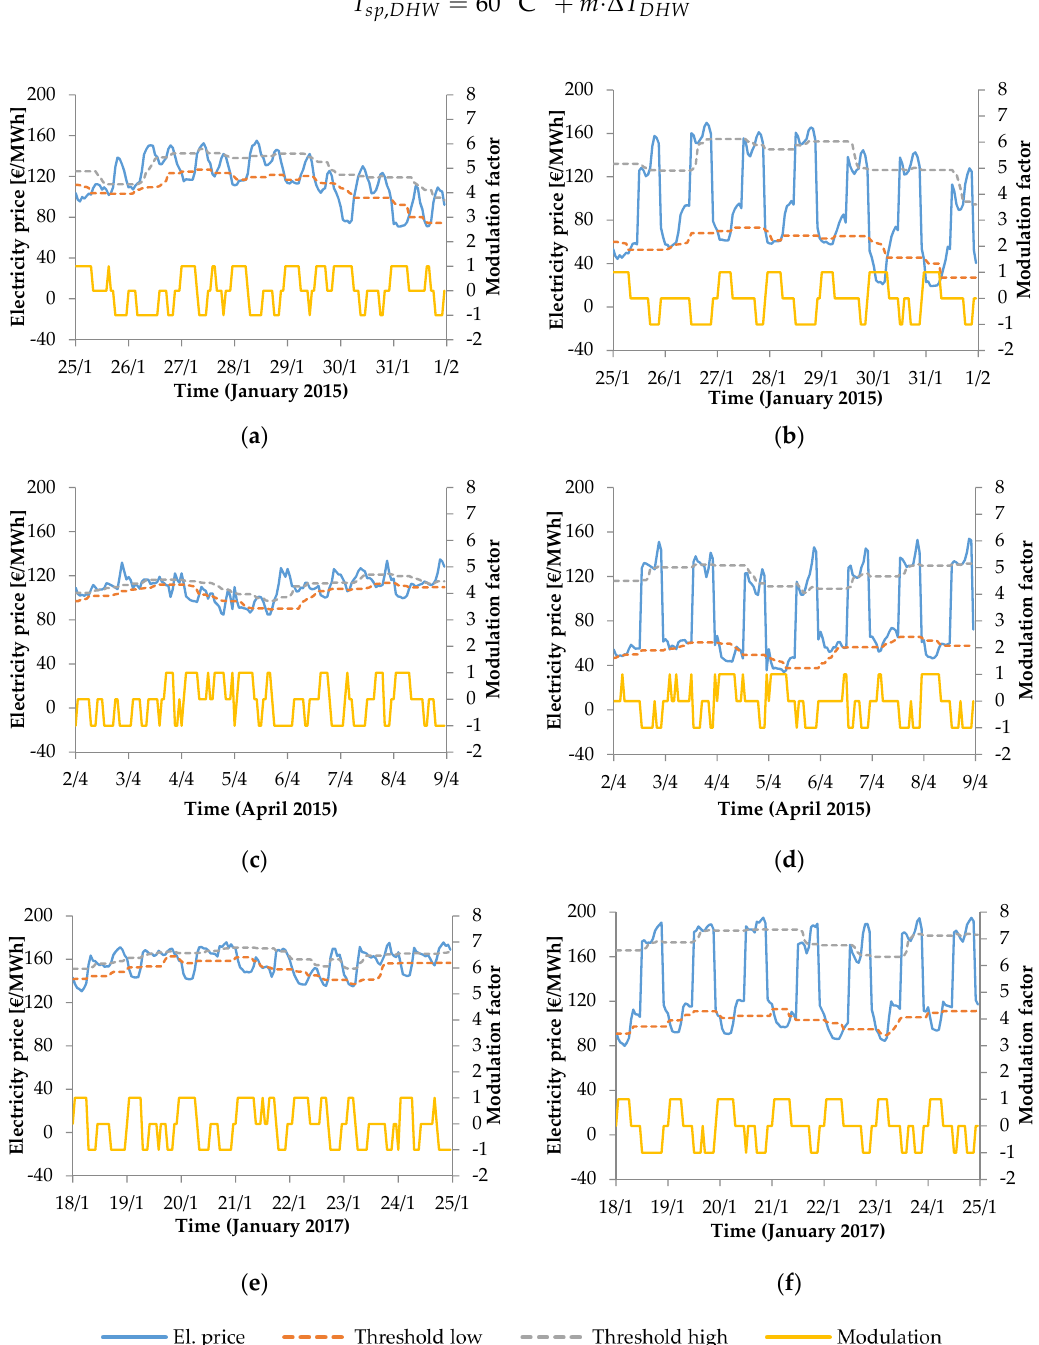
Figure 4. Electricity price for end-users contracted on the PVPC tariff [33] in Spain in January 2015 for graphs ( a , b ); April 2015 for graphs ( c , d ); and January 2017 for graphs ( e , f ). On graphs ( a , c , e ), the default tariff is shown, while on graphs ( b , d , f ), the two-periods tariff is shown. The yellow curves show the modulation factor m , equal to − 1 in the case of a high price, to 1 in the case of a low price, and equal to 0 otherwise. This factor is multiplied afterwards by the amplitude ∆ T to obtain the final set-point modulation (see Equations (3) and